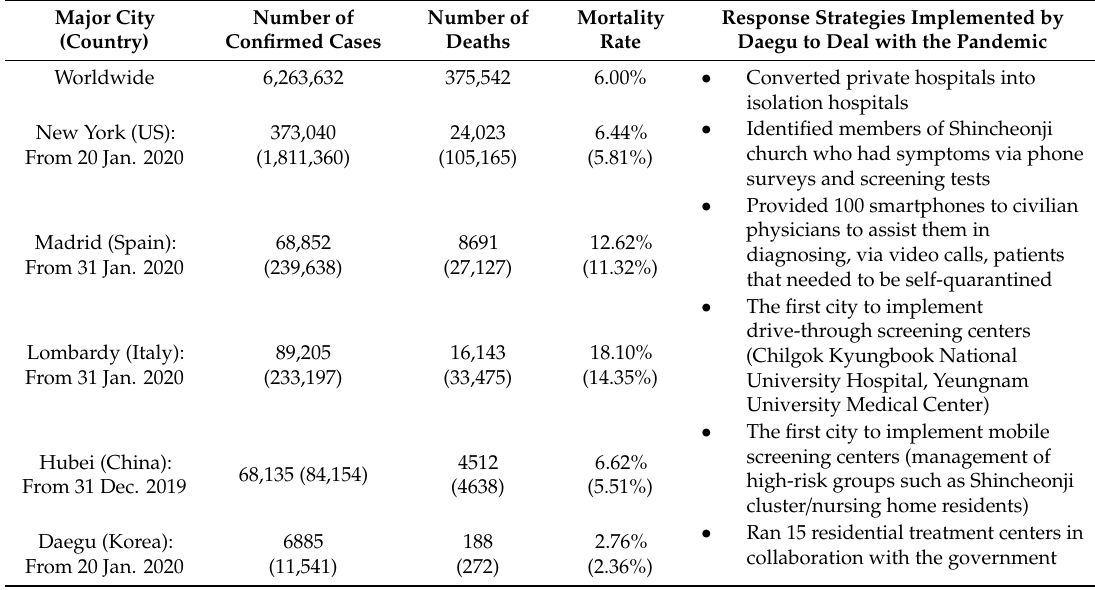
Table 1. Cities most a ff ected by COVID-19 and Daegu’s strategies to combat the pandemic. Major City